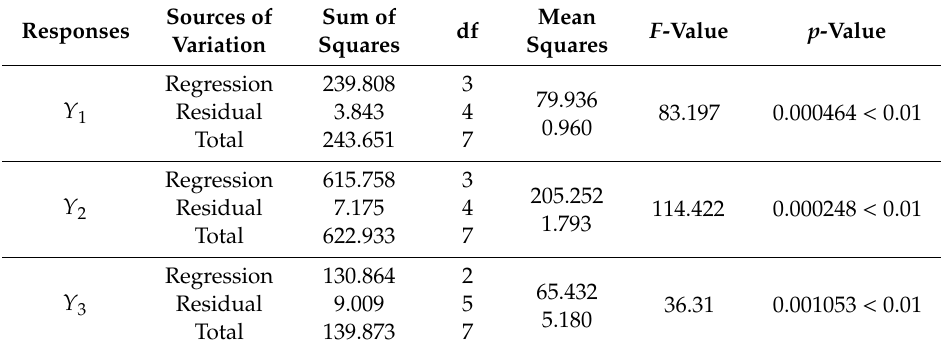
Table 5. Analysis of variance (ANOVA) for reduced regressional polynomial